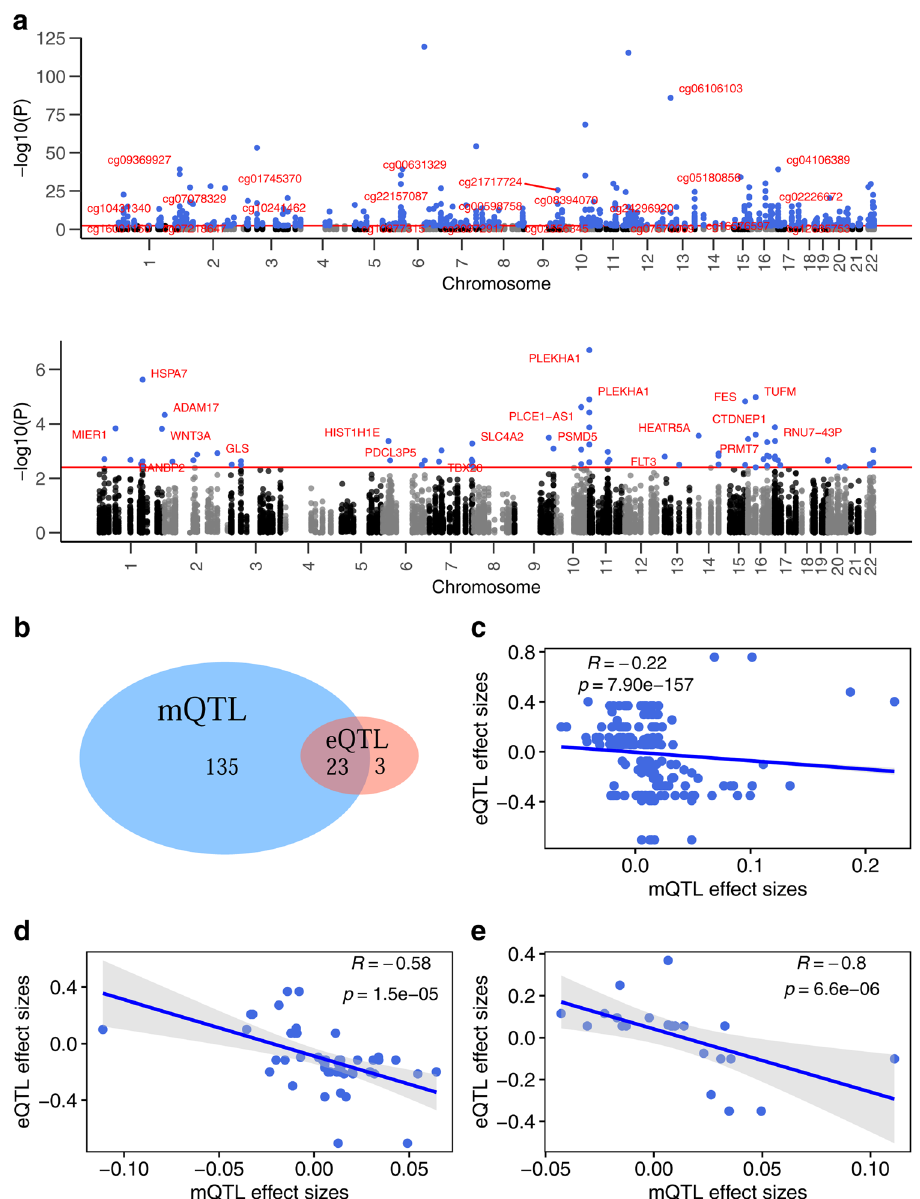
Fig. 2 Birthweight-associated genetic variants with co-occurring cis -eQTL and cis -mQTL effect. a mQTL in the upper panel and eQTL in the lower panel. The red horizontal lines represent the 5% FDR threshold. CpGs and genes with labels correspond to loci in which a genetic variant was associated with both DNA methylation and gene expression. For ease of readability, only one CpG and one gene was labeled per locus. b Venn Diagram showing the number of birthweight GWAS loci that were found to be eQTL and mQTL in the placenta. c – e P is based on a two-sided Spearman correlation test performed between placental mQTL and eQTL association coef fi cients for all 197 eQTL-mQTL triplets ( c ), for 48 triplets consisting DNA methylation sites within the eQTL target genes ( d ), and for 23 triplets that overlap with blood eQTL from GTEx and mQTL from ARIES database ( e ). d , e Error bands in gray represent standard error of the